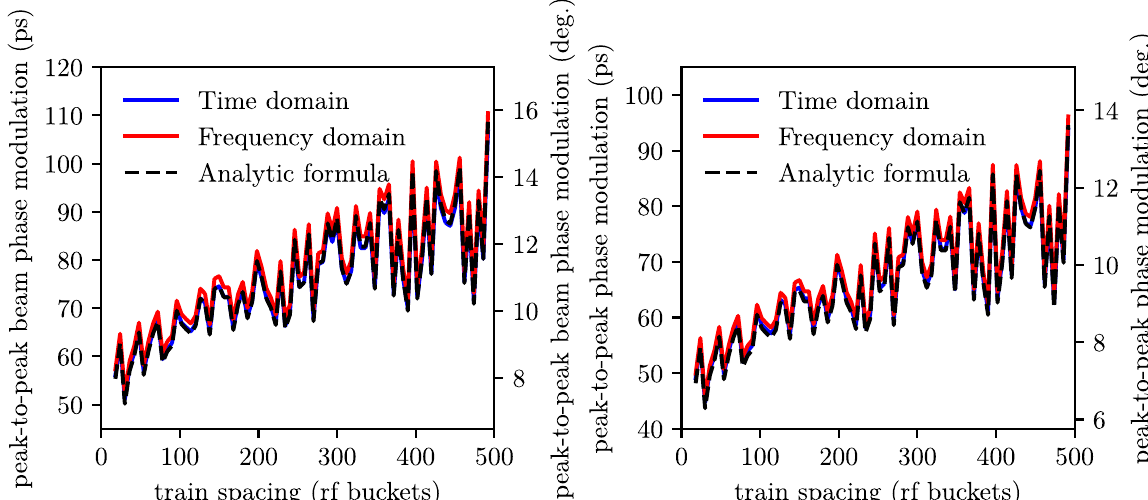
FIG. 6. Dependence of the peak-to-peak values for the beam phase modulation (left) and the phase modulation of the cavity voltage (right) on the train spacing for a bunch spacing of 15 ns. The results from the analytic formulas are given by Eq. (25) (left) and by Eq. (26)